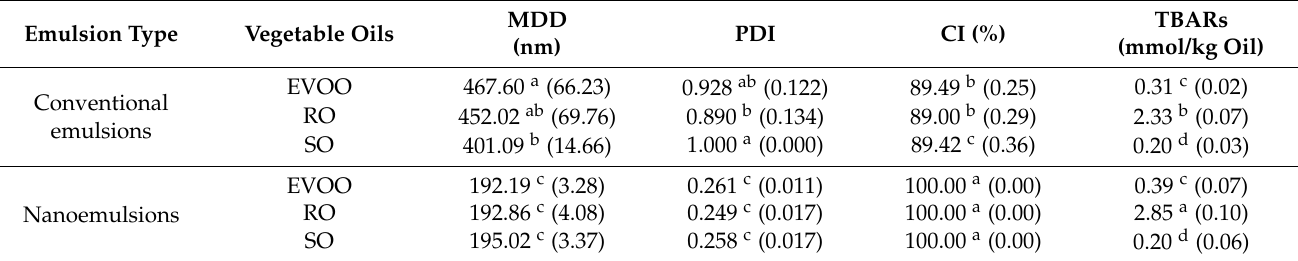
Table 3. Mean droplet diameter (MDD), polydispersity index (PDI), creaming index (CI) and thiobar- bituric acid reactive substances (TBARs) of conventional and nanoemulsions at 25 ◦ C.